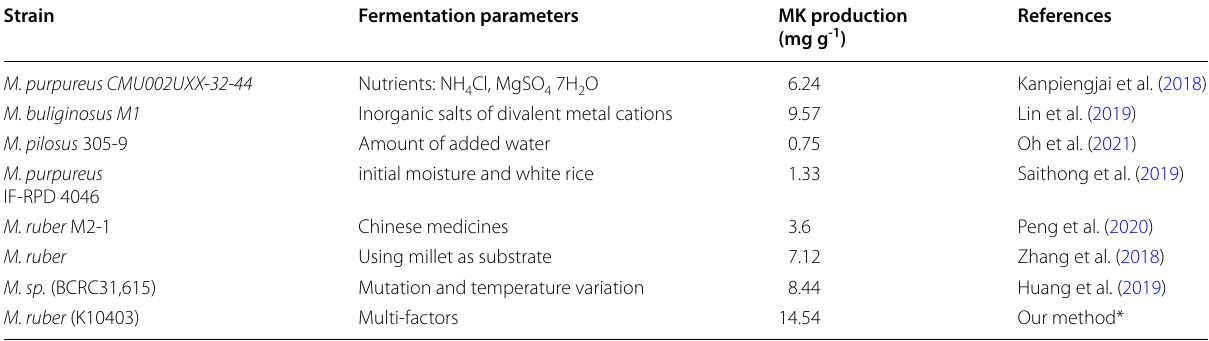
Table 3 Comparison of the present method with recent studies